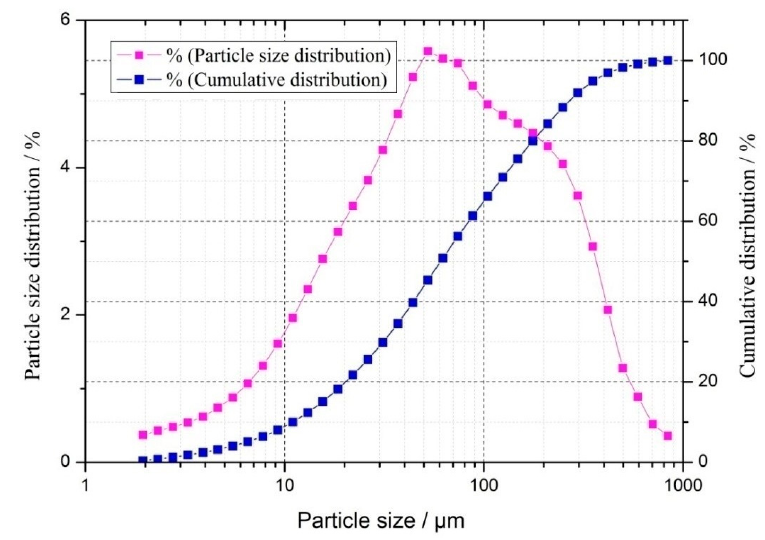
Figure 1. Particle size and cumulative size distribution of raw copper-mine tailings.